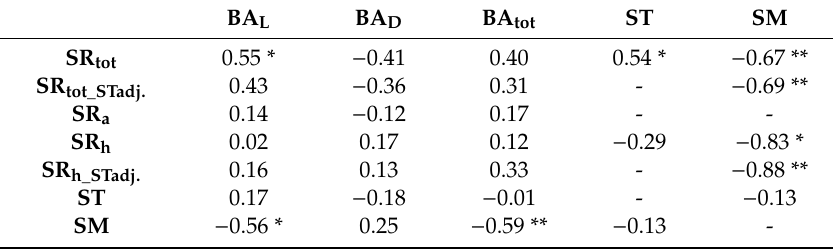
Table 3. Spearman’s correlation coe ffi cients between various plot mean soil surface respiration and soil temperature, soil moisture, and stand basal area. BA L = living, BA D = dead, and BA tot = all trees, ST = soil temperature, SM = soil moisture, SR tot = soil surface total respiration, SR tot_STadj. = temperature-adjusted soil surface total respiration (Aug–Oct 2016 and May–Oct 2017 data, n = 16). SR a = autotrophic respiration, SR = measured, and SR = soil-temperature-adjusted heterotrophic h h_STadj. respiration (May–Oct 2017 data, n =